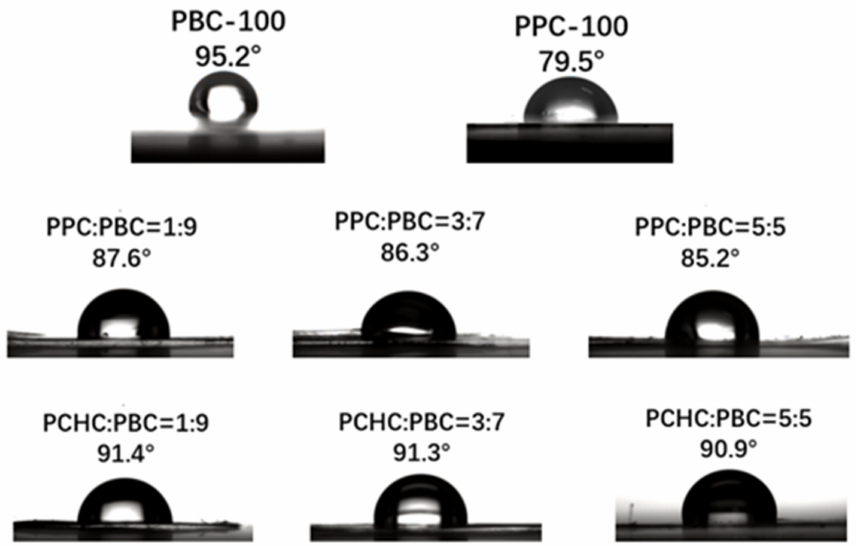
Figure 5. Water contact angles of CO 2 -based